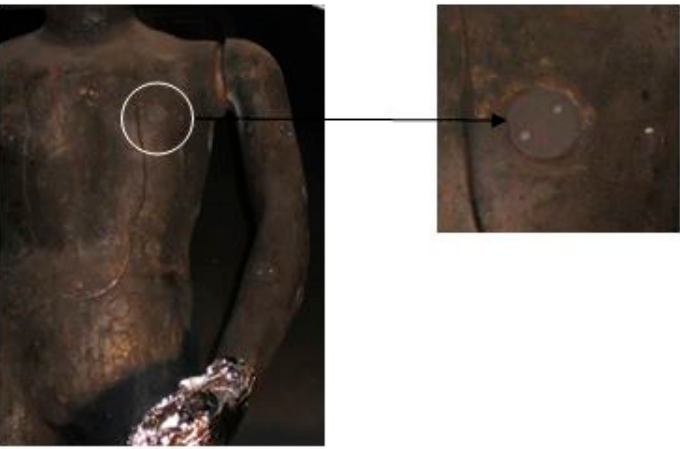
Figure 4. Temperature sensor on the fire manikin.